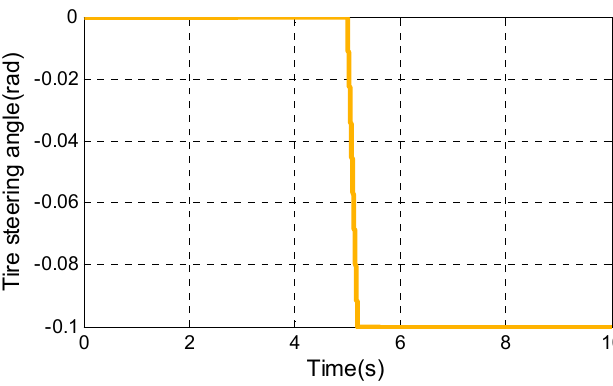
Figure 2. Steering angle of tires in the Pacejka tire simulation.